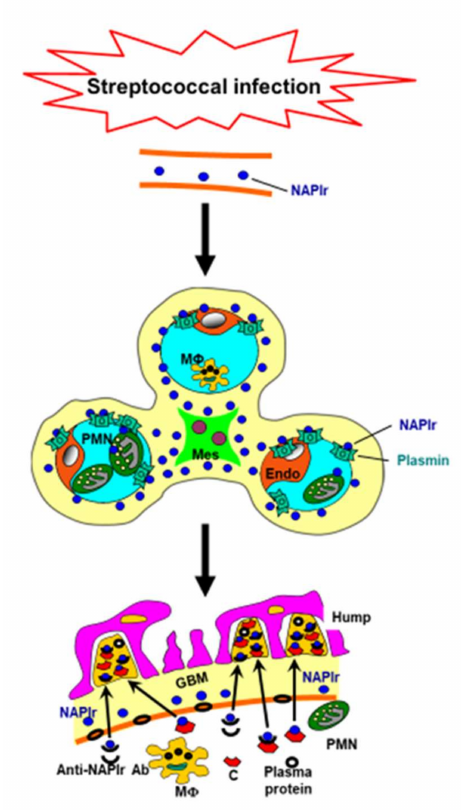
Figure 1. Putative mechanism for the development of poststreptococcal acute glomerulonephritis. Streptococcal infection induces the release of nephritogenic proteins, such as nephritis-associated plasmin receptor (NAPlr), into the circulation. Circulating NAPlr accumulates on the inner side of the glomerular capillary walls, and then traps and maintains the activity of plasmin, which induces glomerulardamagebythedegradationofextracellularmatrixproteinsorbyactivatingandaccumulating inflammatory cells. Thereafter, immune complexes, formed either in situ or in the circulation, pass through the altered glomerular basement membrane (GBM). Accumulation of immune complexes, complements, and plasma proteins forms “humps” on the outer side of the glomerular capillary walls. This scheme is based on the figure from Oda et al. [2]. Ab: antibody; C: complement; Endo: endothelial cell; Mes: mesangial cell; M Φ : macrophage; PMN: polymorphonuclear